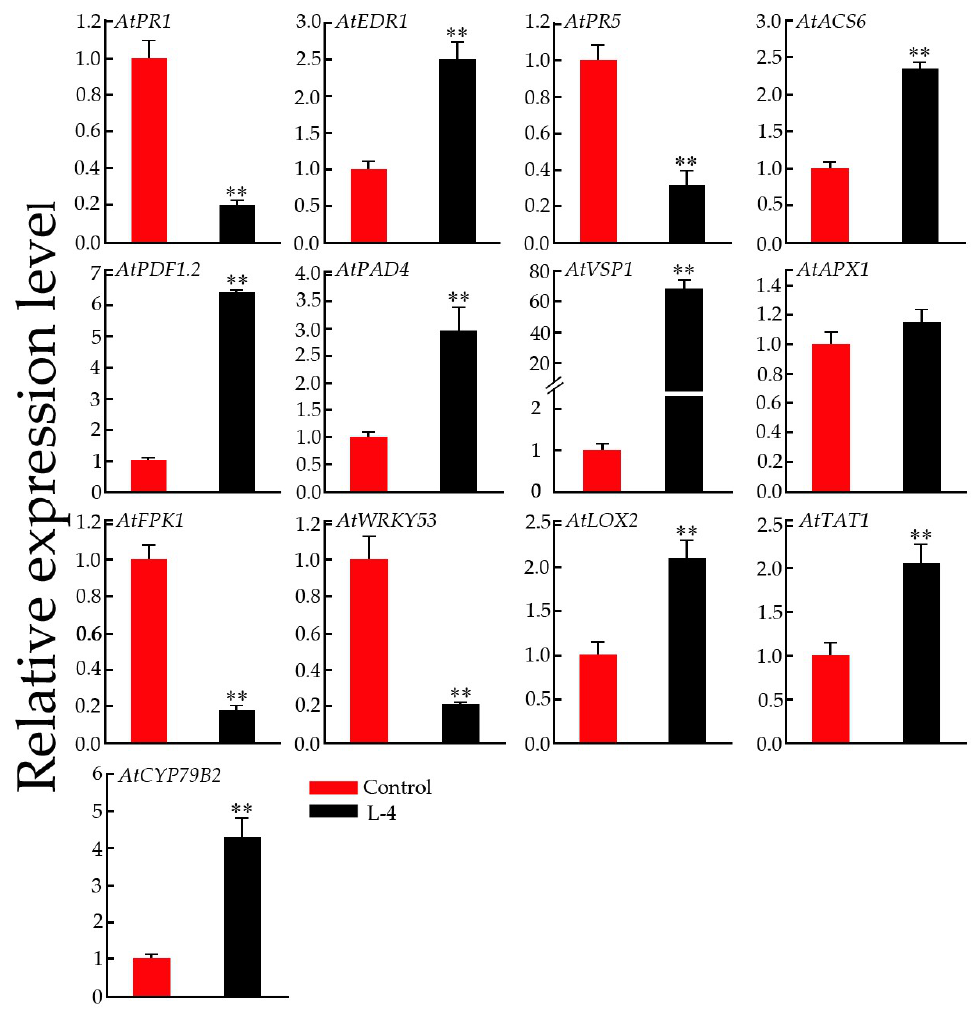
Figure 9. QPCR analysis of the expression levels of defense-related genes in the control (Col-0) and transgenic (L-4) Arabidopsis plants. Arabidopsis actin 1 ( AtActin1 ) was used as an internal standard to normalize the templates. The relative mRNA levels are represented as the mean ± SD ( n = 3). Statistically significant differences were assessed using Student’s t -test (** p < 0.01).